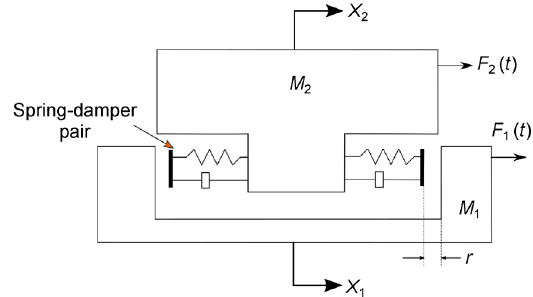
Fig. 9 Simple dynamic link coupling with clearance which leads to the “impact pair” condition based on Ref. [96].